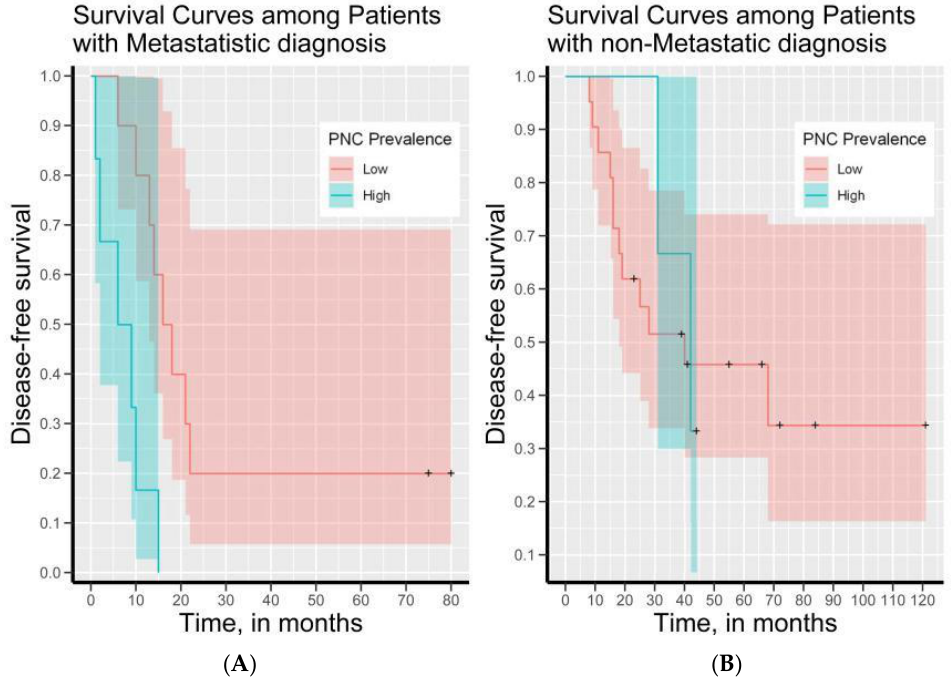
Figure 2. Kaplan–Meier analysis revealing poor progression-free survival among patients with metastatic diagnosis ( A ) and among patients with non-metastatic diagnosis ( B ).